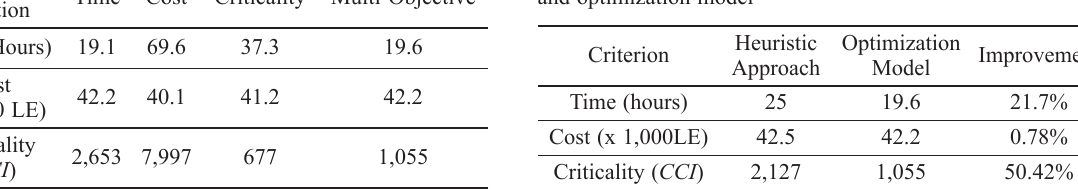
Table 6. Comparison between water utility heuristic and optimization